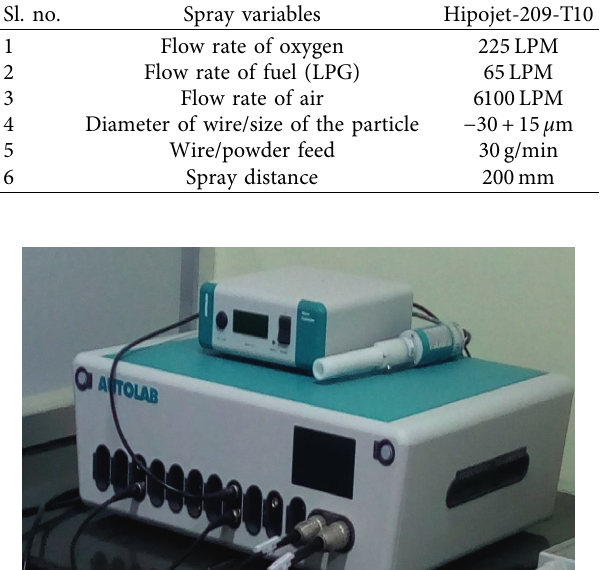
Table 3: Spray variables utilized during HVOF showering. Sl. no.